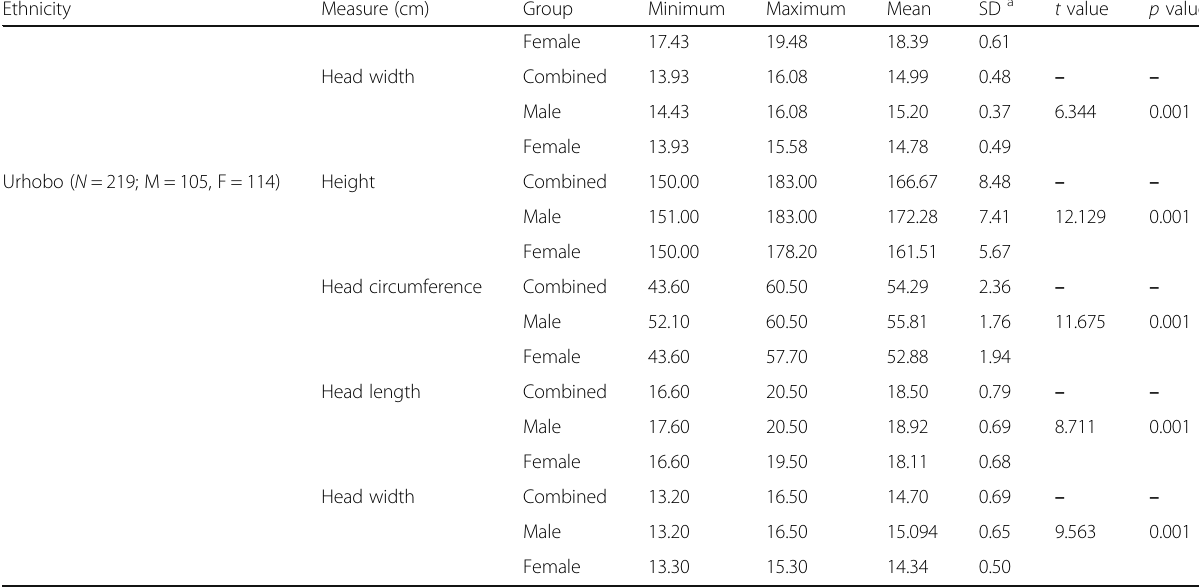
Table 1 Comparison of measured parameters between males and females in the five ethnic groups (Continued) Ethnicity Measure (cm)